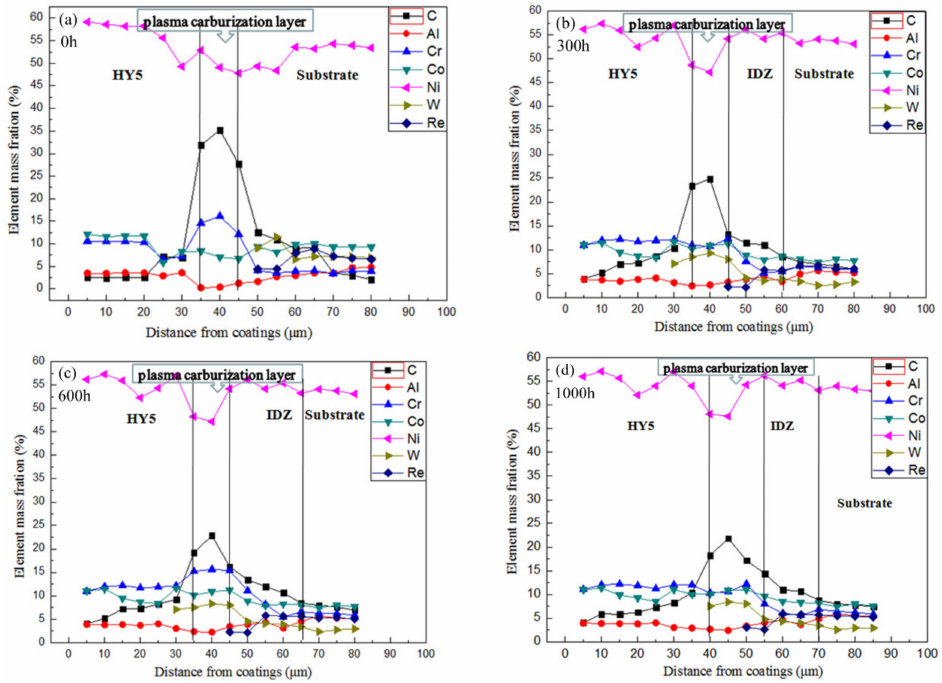
Figure 7. Chemical compositions of the carburized Ni-based single-crystal superalloy with an HY5 coating at 1100 ◦ C after thermal cyclic oxidation: ( a ) 0 h; ( b ) 300 h; ( c ) 600 h; ( d ) 1000